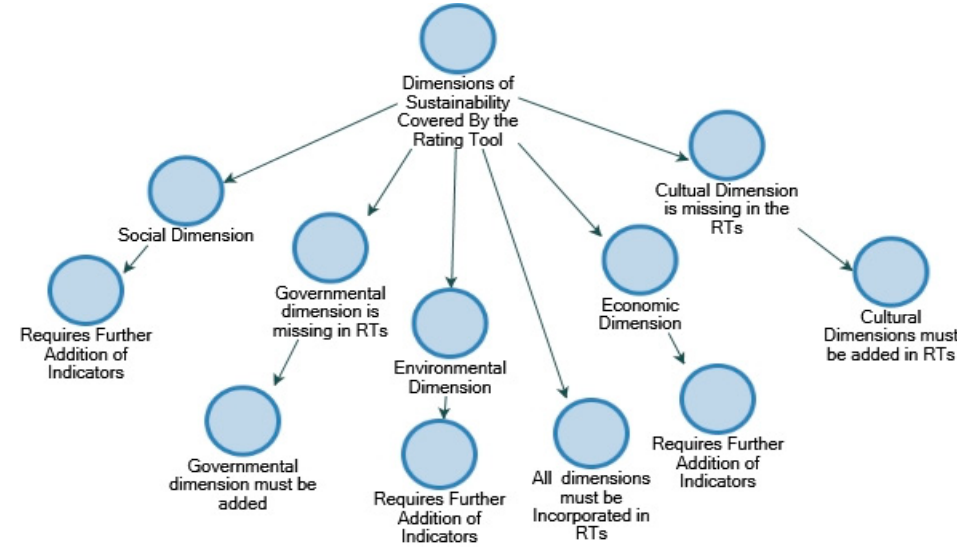
Figure 3. Responses of interviewees on dimensions of sustainability covered by rating tools.